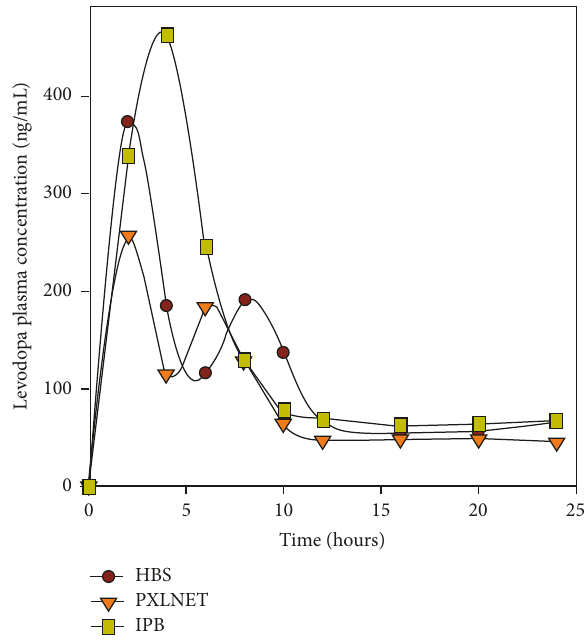
Figure 8: Comparative L-dopa pharmacokinetic curve of Madopar HBS capsules and PXLNET and IPB matrices after single dose